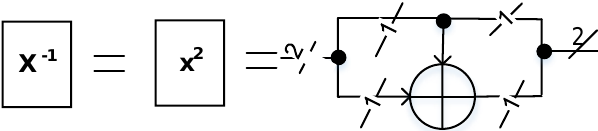
Figure 2. Proposed S-box structure in finite fields. The affine and the inverse transformations are carried out in the field GF (2 4 ) and the multiplicative inversion is carried out in the composite field GF ((2 2 ) 2 ) .